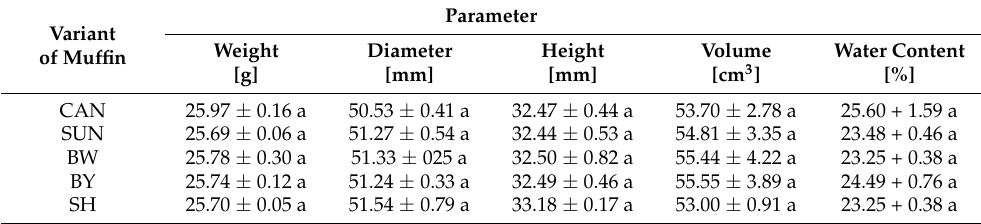
Table 2. Weight, geometric dimensions, volume, and water content of a muffin.